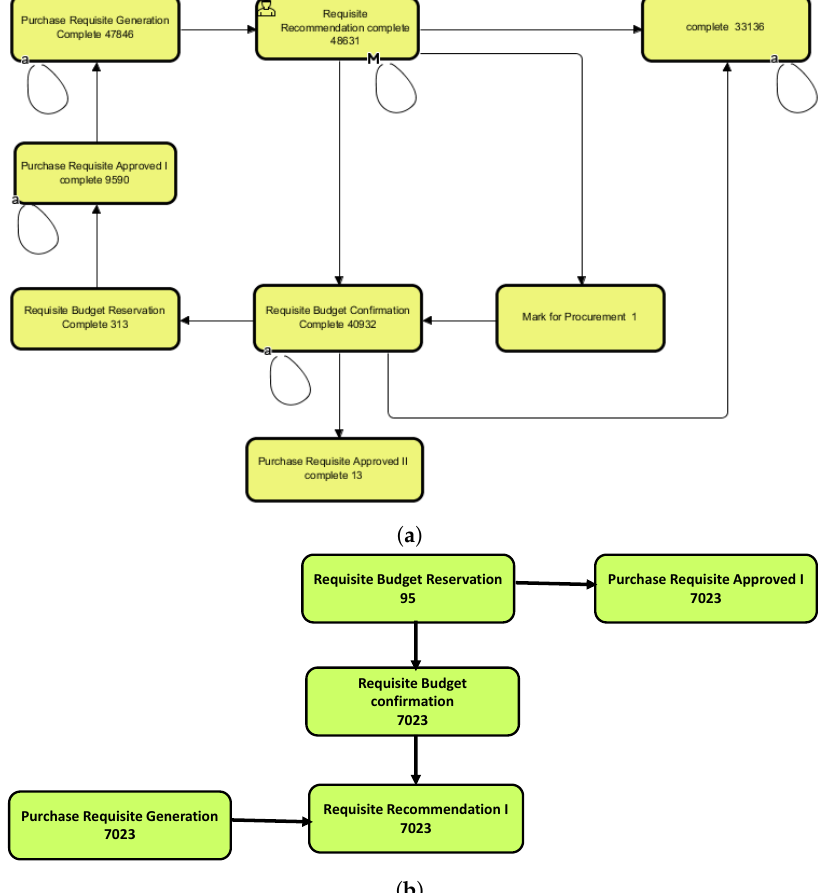
Figure 8. ( a ) Petri net generated by fuzzy miner on the original noisy data, and ( b ) Petri net generated by heuristic net on refined